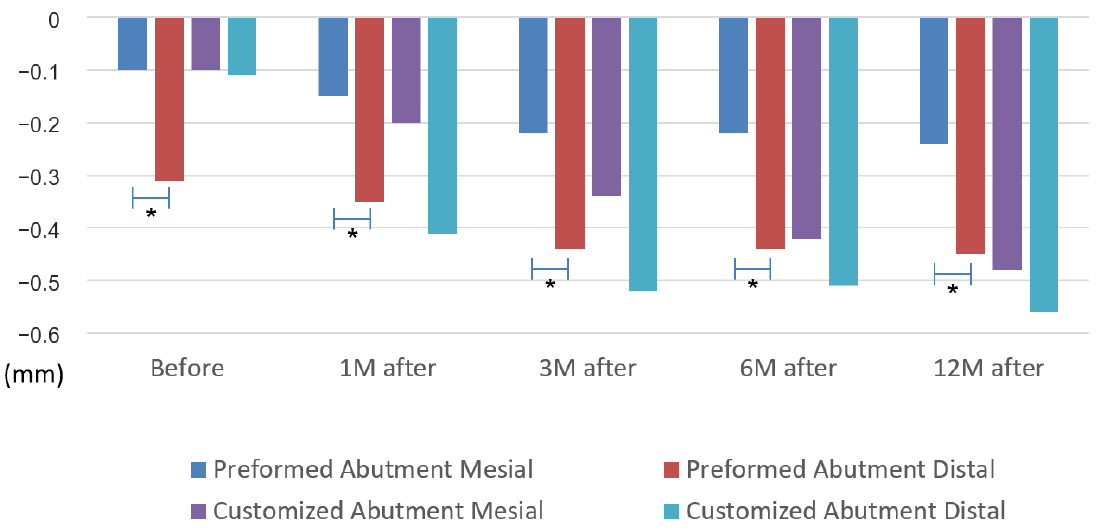
Figure 3. Measurement data of mesial and distal bone levels in each period. (* p < 0.05, by two-tailed t -test.).